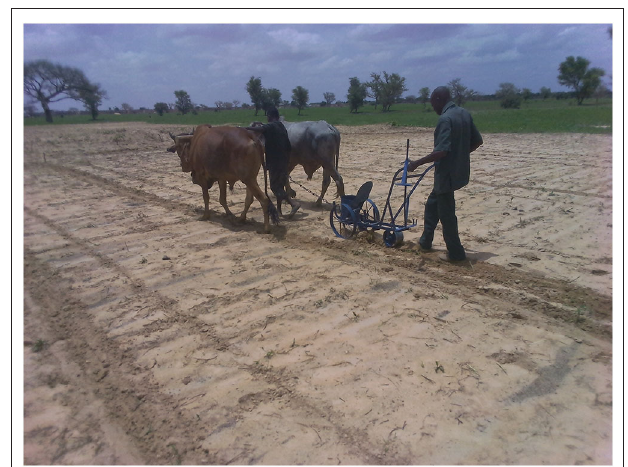
FIGURE 1 | A farmer is sowing pearl millet using the super-eco planter.